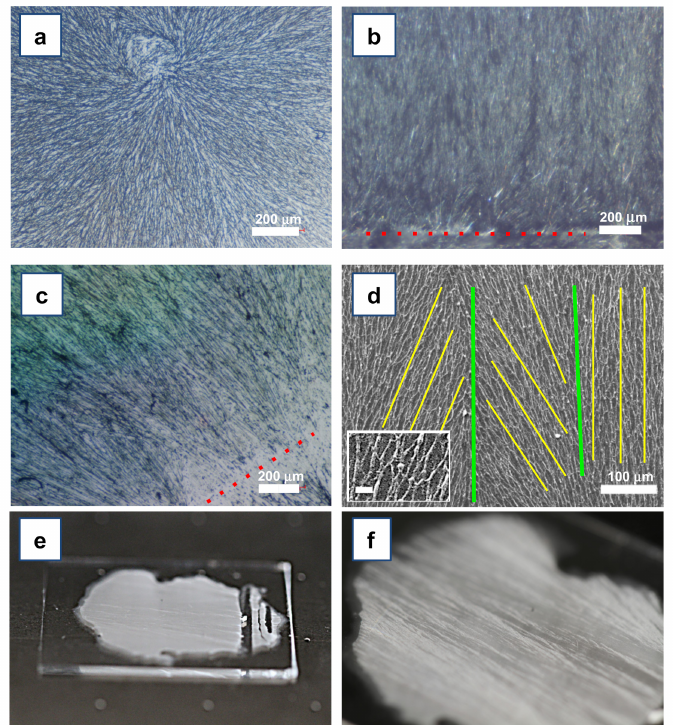
Figure 5. ( a ) Sparse and randomly oriented PLGA nanofibers obtained by standard (nondirec- tional) ASB-SANS procedure, using menthol as Sublimating Substance. ( b ) Micrograph of aligned PLGA-incorporating menthol crystals obtained using a single crystal of pure menthol as seed for multiepitaxial growth (see Figure S4 for a standard photographic view of the system). The dotted red line at the bottom of the image identifies the edge of the menthol seed crystal. ( c ) Optical micrograph of aligned PLGA nanofibers obtained via the sublimation of menthol from the same system shown in Figure 5b. The red dotted line identifies the main axis of the menthol seed crystal. ( d ) SEM image of the same PLGA nanofibers imaged in Figure 5c by optical microscopy. The green lines identify different domains of orientation of the fibers; the yellow lines highlight the main axis of the domain. In the inset, a magnification of the obtained fibers is shown (scale bar: 10 µ m). ( e , f ) Optical photographs of menthol/PLGA crystals grown using the Directional ASB-SANS protocol on a glass slide of about 2.5 cm × 5 cm size. ( e ) View of a glass slide coated with aligned crystals grown by the Directional ASB-SANS. The seed crystal was removed to highlight its position during the